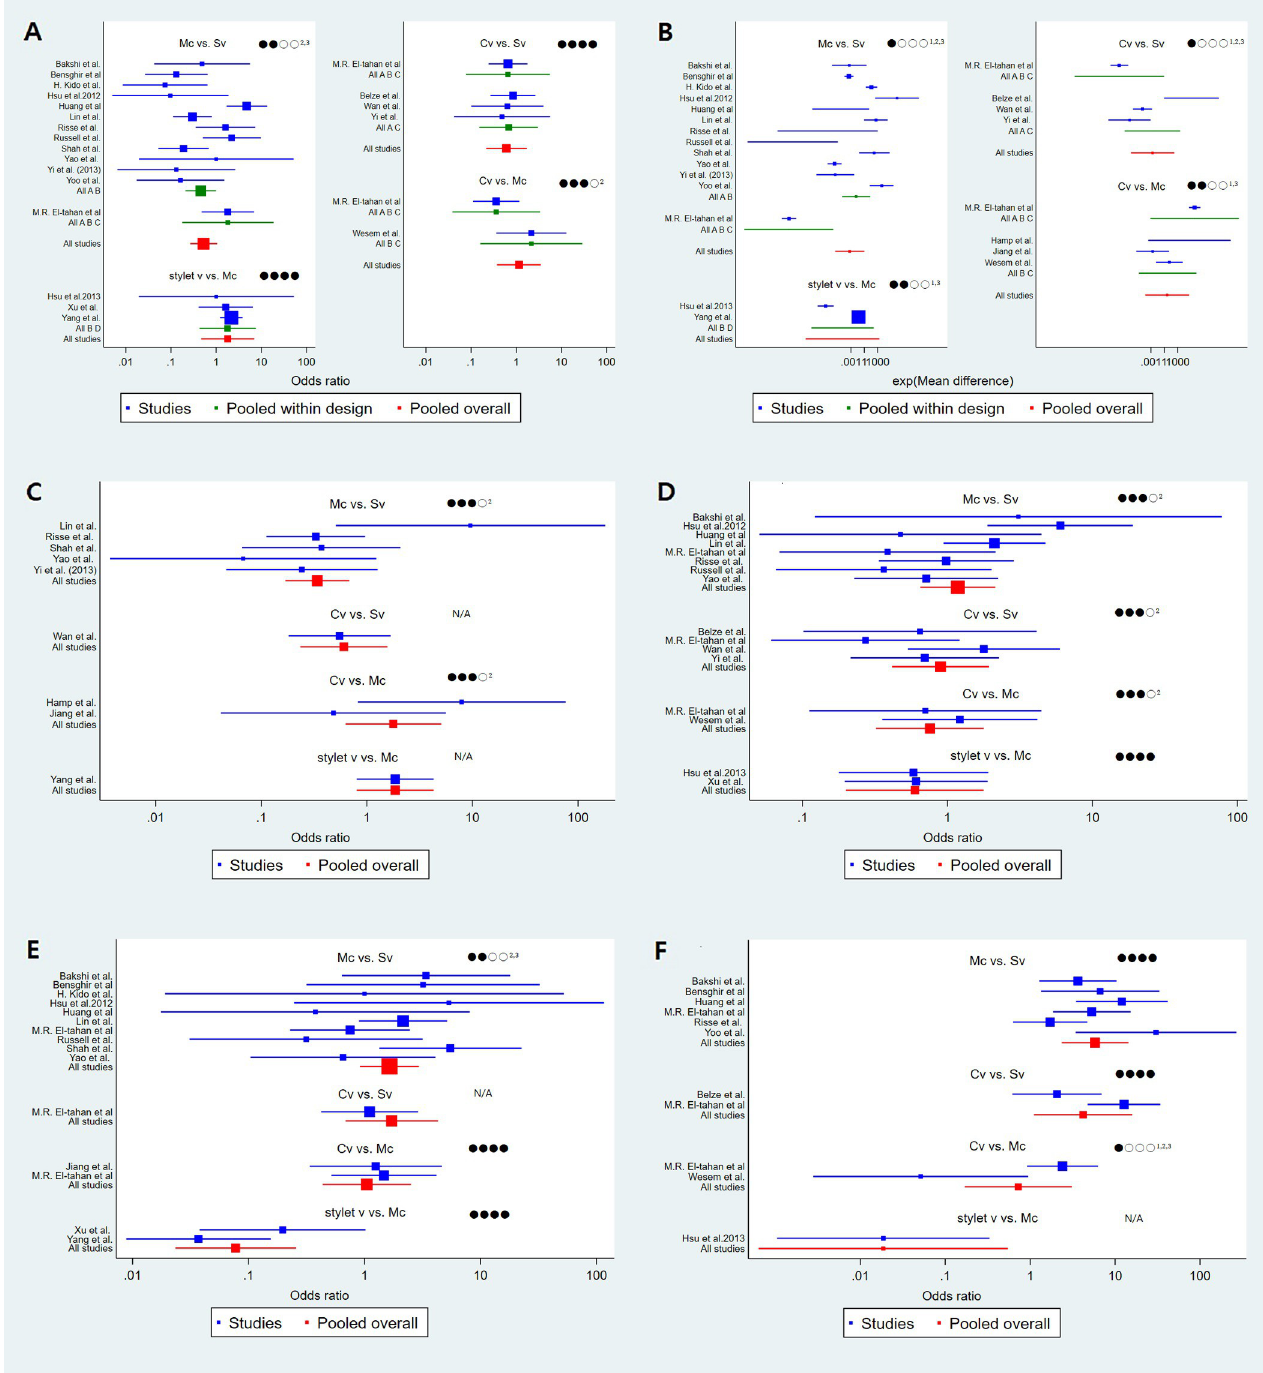
Fig 5. The estimated pair-wise summary effects of outcomes that show the 95% CI and PrI of the estimates and the GRADE score. A GRADE score was assessed in each comparison. 1 high inconsistency, 2 high indirectness, 3 high imprecision (wide CI). (A) The success rate of the first attempt, (B) intubation time, (C) malposition, (D) sore throat, (E) oral mucosal damage, and (F) external manipulation. Mc, Macintosh (direct) laryngoscope; SV, standard non-channeled videolaryngoscope; CV, channeled videolaryngoscope; stylet V, videostylet.